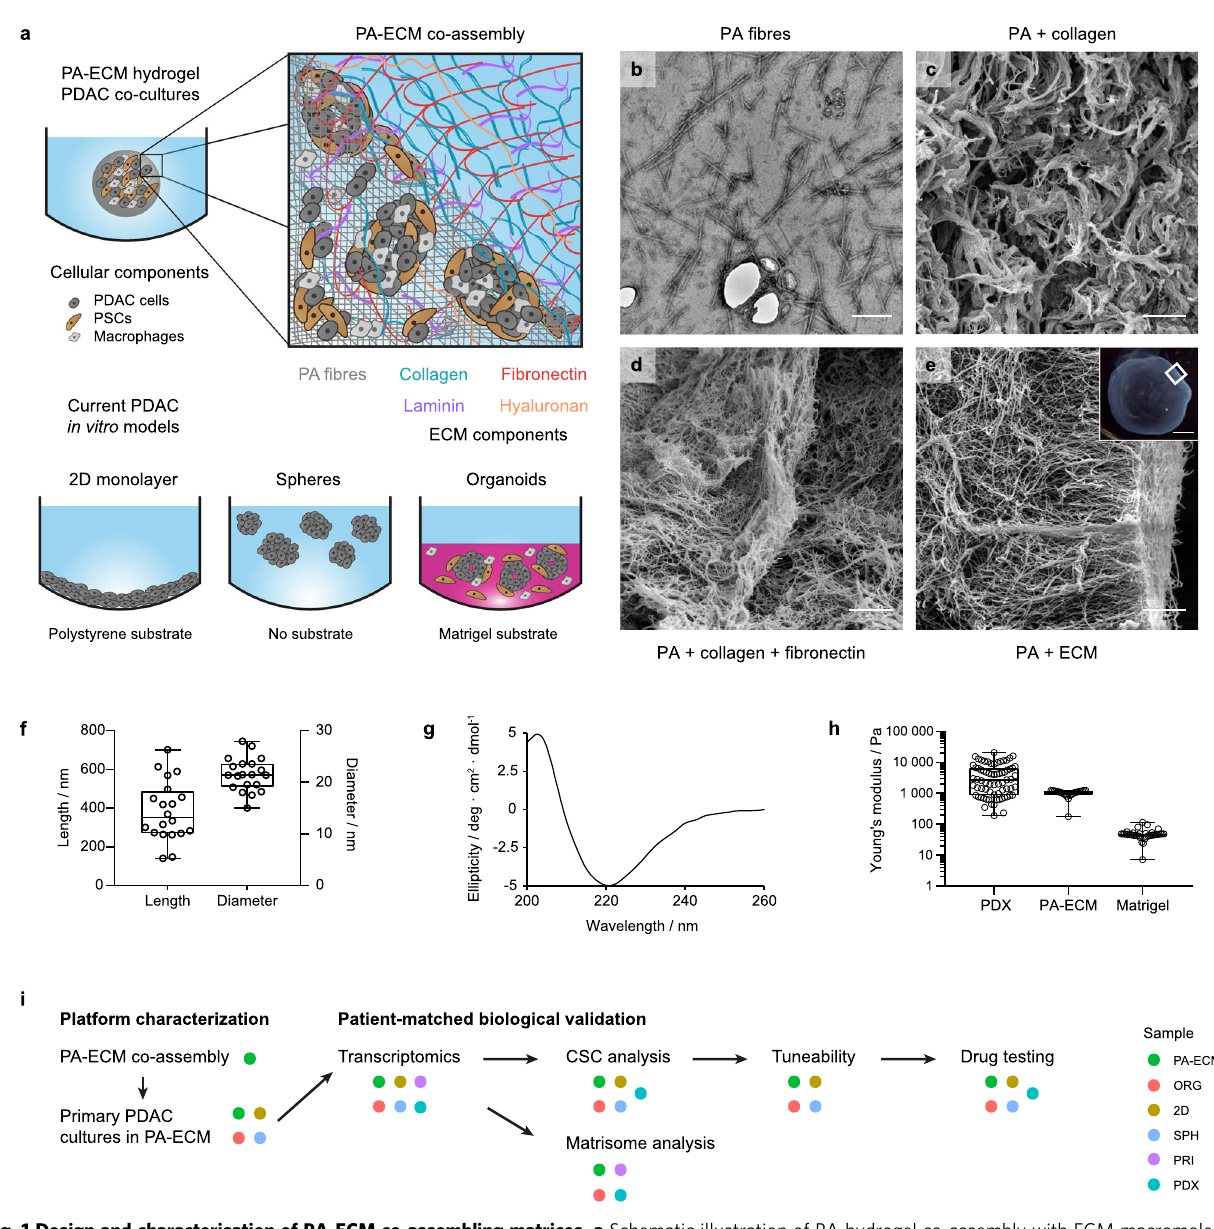
Fig. 1 Design and characterisation of PA-ECM co-assembling matrices. a Schematic illustration of PA hydrogel co-assembly with ECM macromolecules compared to currently used substrates for the in vitro modelling of PDAC. b Transmission electron micrograph of PA fi bres. Scale bar: 100 µ m. c – e Scanning electron micrographs of PA hydrogels co-assembled with collagen (c), collagen and fi bronectin (d) and all ECM components (e); insert indicates imaged area within a 2 µ L hydrogel. Scale bar: 2 µ m. Insert scale bar: 500 µ m. f PA fi bre size measured from TEM micrographs. Box plots indicate range, interquartile range and median. n = 20 individual fi bres. g PA fi bre circular dichroism spectrum in HEPES buffer. h Stiffness (Young ’ s modulus) of PDX tissue, as measured by atomic force microscopy ( n = 71 measurements across a tissue section), compared to PA-ECM ( n = 24 measurements of a 10 mg/mL gel) and Matrigel ( n = 38 measurements of a 10 mg/mL gel), as measured by rheometry. Box plots indicate range, interquartile range and median. i Experimental outline for the validation of the platform as a model for pancreatic